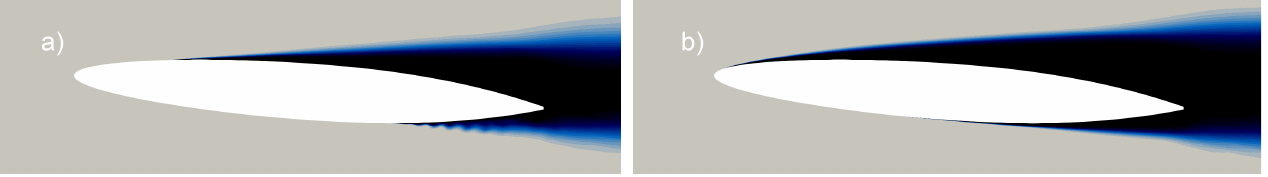
Figure 13. Sheet cavitation prediction of NACA16012, AoA = 4 ◦ , Re = 1,000,000, σ = 0.045. ( a ) bridged model; ( b ) unbridged k − ω SST + SS .